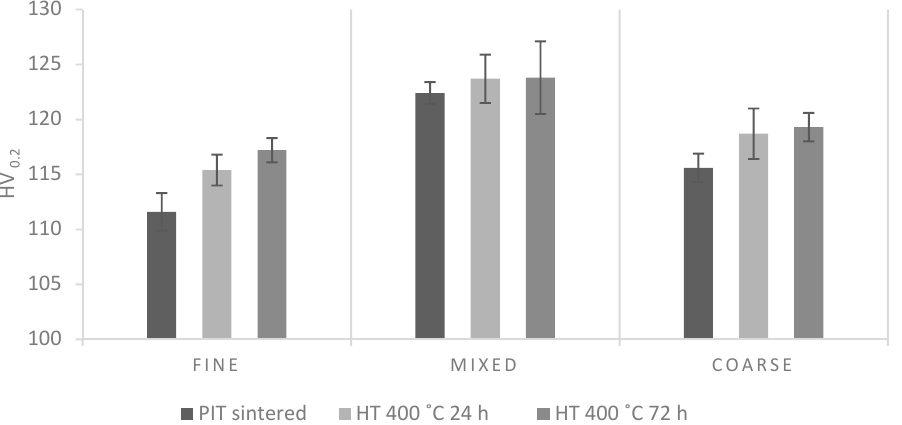
Figure 10. HV 0 . 2 microhardness in fine, mixed 50–50 and coarse Al-8Ce-10Mg wt % powders via PIT before and after heat treatment at 400 °C for 24 h and 72 h.